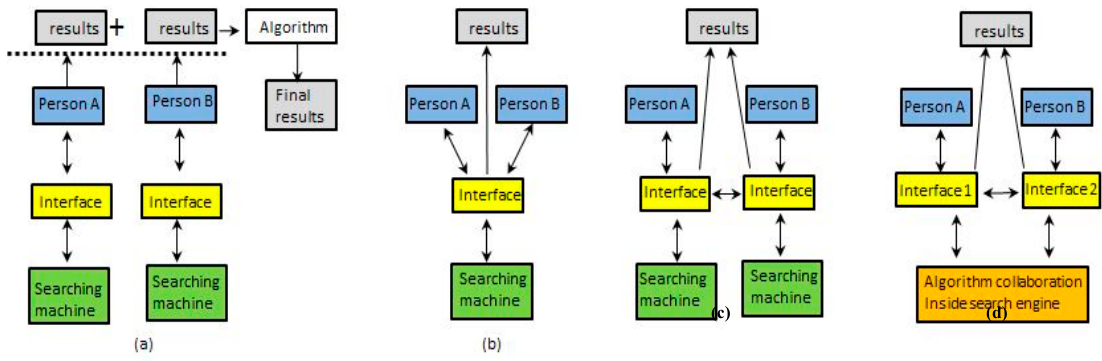
Figure 1. Strategies for Collaborative Search (according to [7]). In ( a ) an algorithm automatically combines results obtained individually by two or more users. In ( b ) multiple users interact with the same interface thus producing one result. In ( c ) multiple users interact with multiple interfaces but results are combined (e.g., summed). In ( d ) the collaboration happens inside the search